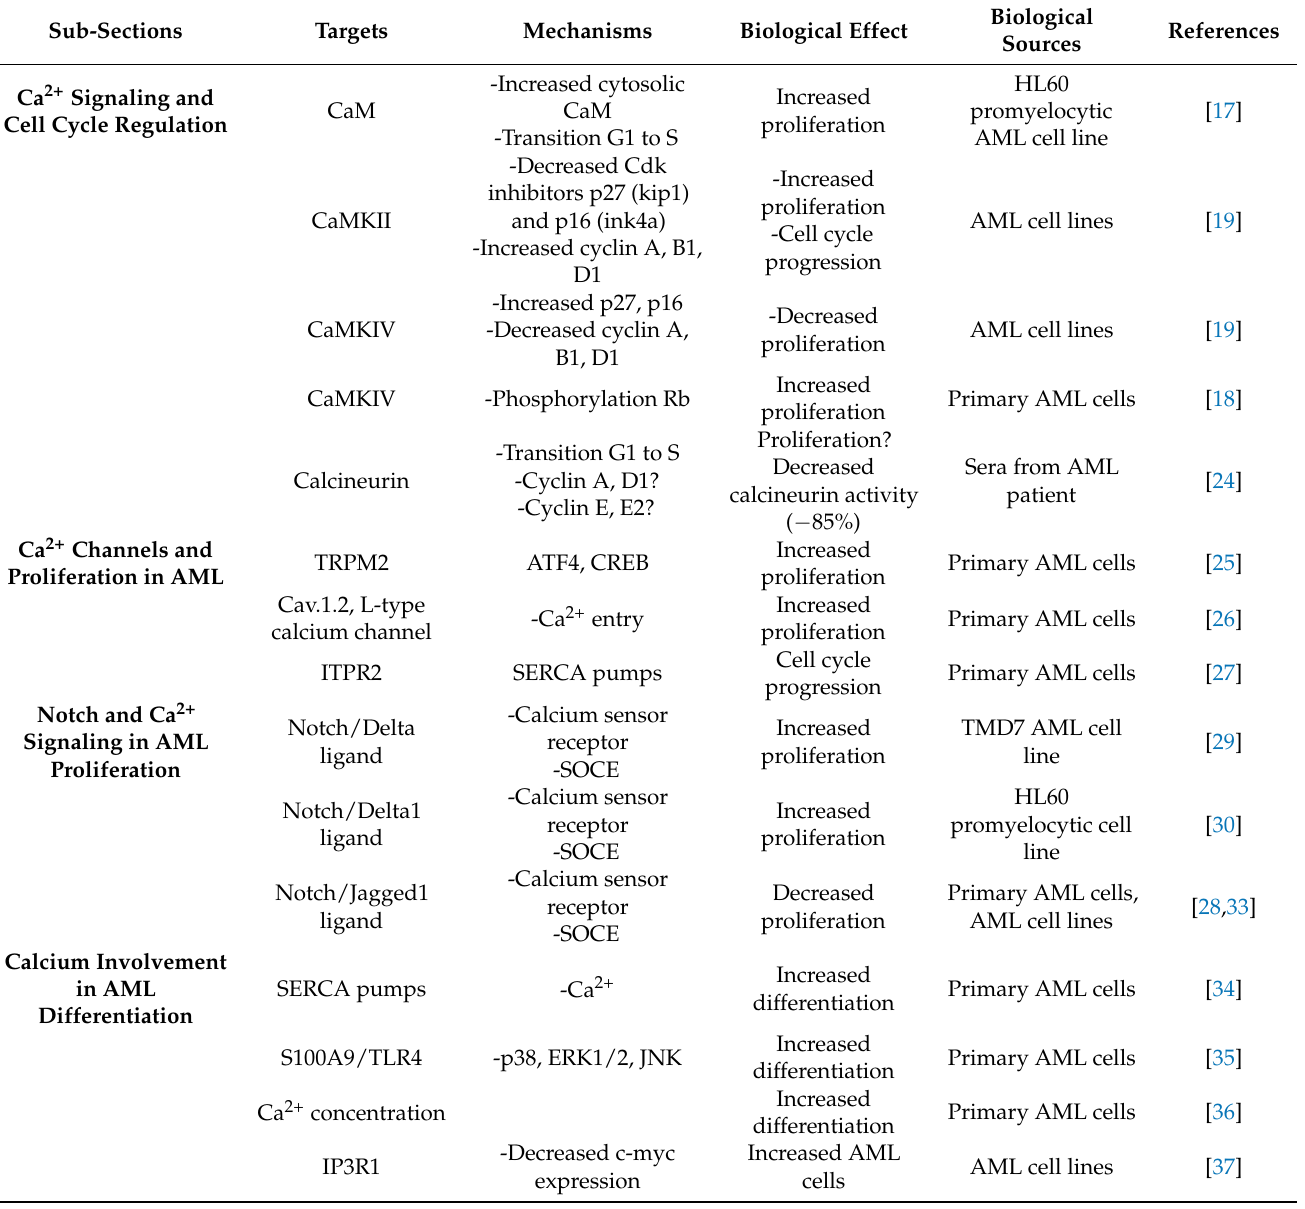
Table 1. Summary of the main targets/pathways of interest associated with calcium signaling and related to AML proliferation and